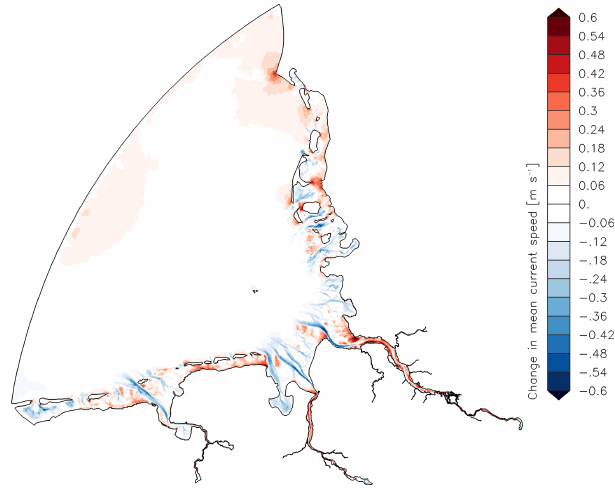
Figure 10. Change in total mean current speed (depth averaged and analysed over a spring–neap cycle in July 2010) due to MSLR of 10m (increase in red, decrease in blue)